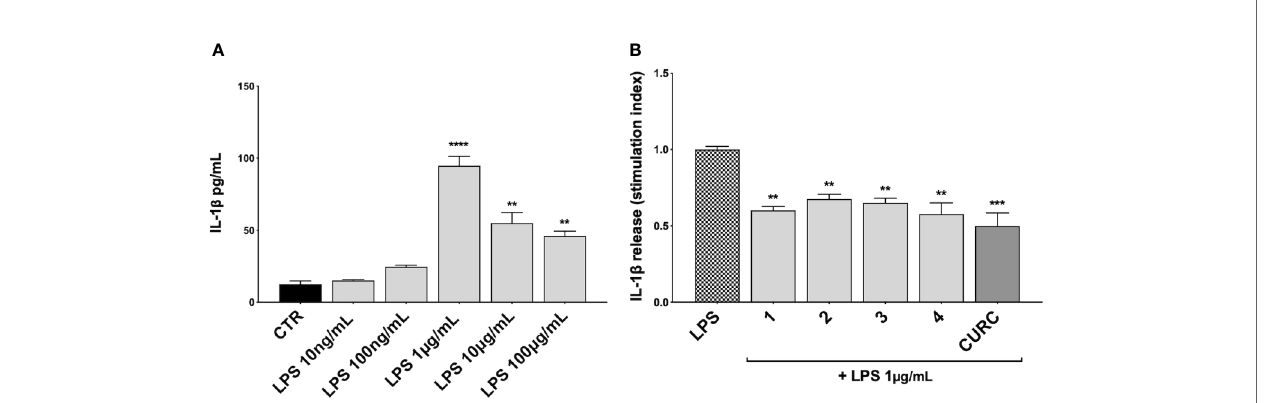
FIGURE 4 | Modulation of IL-1 b release in LPS-stimulated THP-1 cells. (A) IL-1 b protein secretion was measured in THP-1 cell supernatants stimulated with LPS at the indicated concentrations for 3 h. At the end of the treatment, IL-1 b protein release was assessed by ELISA. Data are presented as means of released picograms per mL (pg/mL) ± SEM. Dunnett ’ s multiple comparison test; ** p < 0.01 and **** p < 0.0001 versus CTR; n = 3. (B) IL-1 b protein release was measured in THP-1 cells supernatants, treated for 24 h with compounds 1 – 4 and CURC at a concentration of 5 m M and then stimulated with 1 m g/mL LPS for 3 h. The level of IL-1 b was assessed by ELISA. Data are presented as means of stimulation index ± SEM. Dunnett ’ s multiple comparison test; ** p < 0.01 and *** p < 0.001 versus CTR; n =